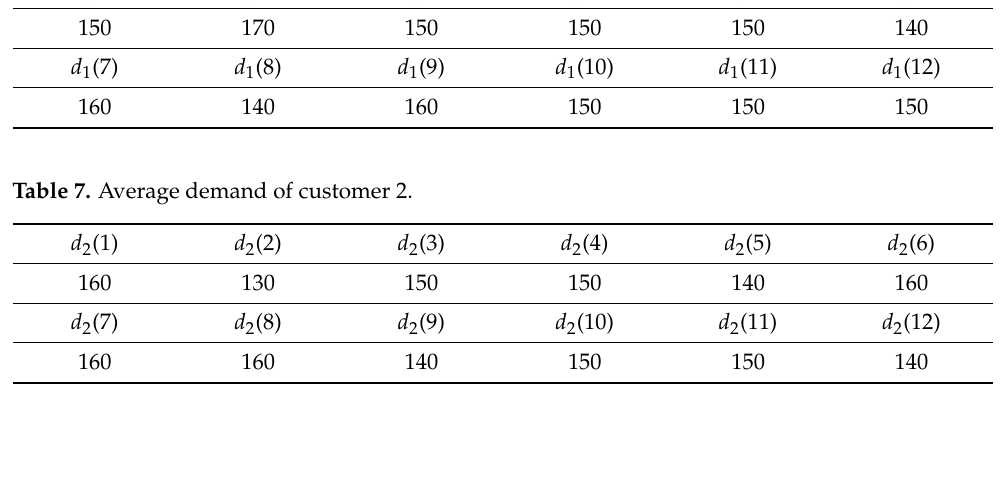
Table 9. Economical delivery plan for warehouse 1 ( τ * = 1).